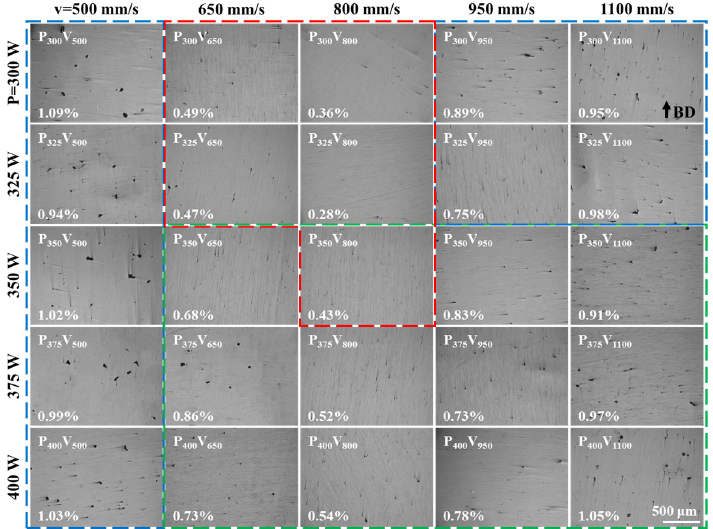
Figure 3. The metallographic microstructure of the XZ plane of the as-built samples (the lower-left corner shows the porosity, samples with a relative density higher than 99% are marked with a red box, as-built samples with irregular pores are marked with a blue box, and those with circular pores are marked with a green box).